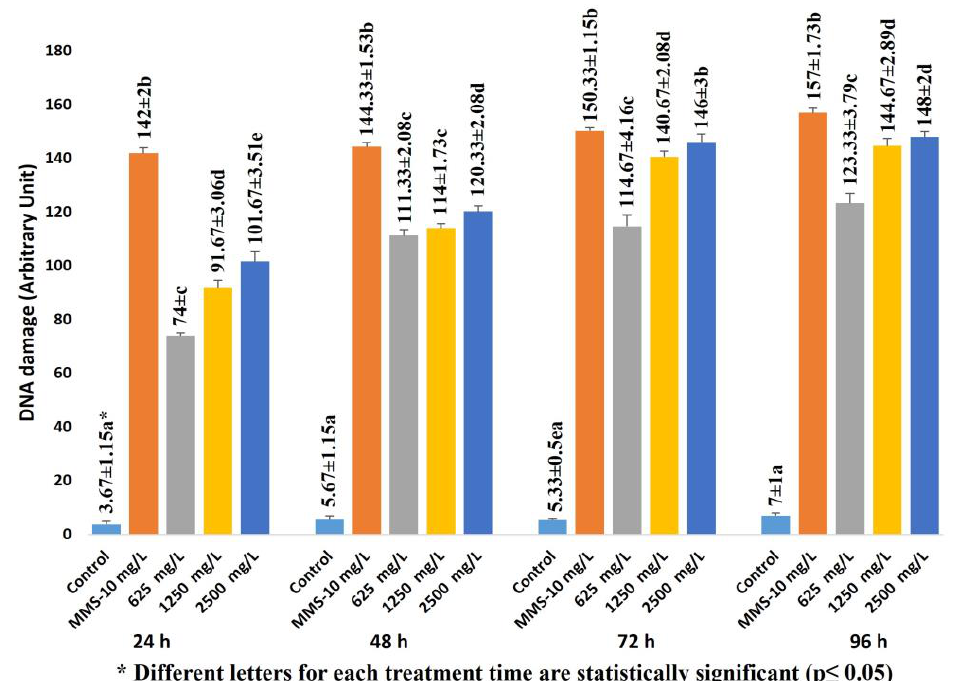
Figure 4. DNA damage induced by FLB in A. cepa roots. Dose dependent: For 24 h, r = 0.969; p = 0.01. For 48 h, r = 0.895; p = 0.01. For 72 h, r = 0.918; p = 0.01. For 96 h, r = 0.900; p = 0.01. Time dependent: For 625 mg/L, r = 0.888; p = 0.01. For 1250 mg/L, r = 0.962; p = 0.01. For 2500 mg/L, r = 0.953; p = 0.01.